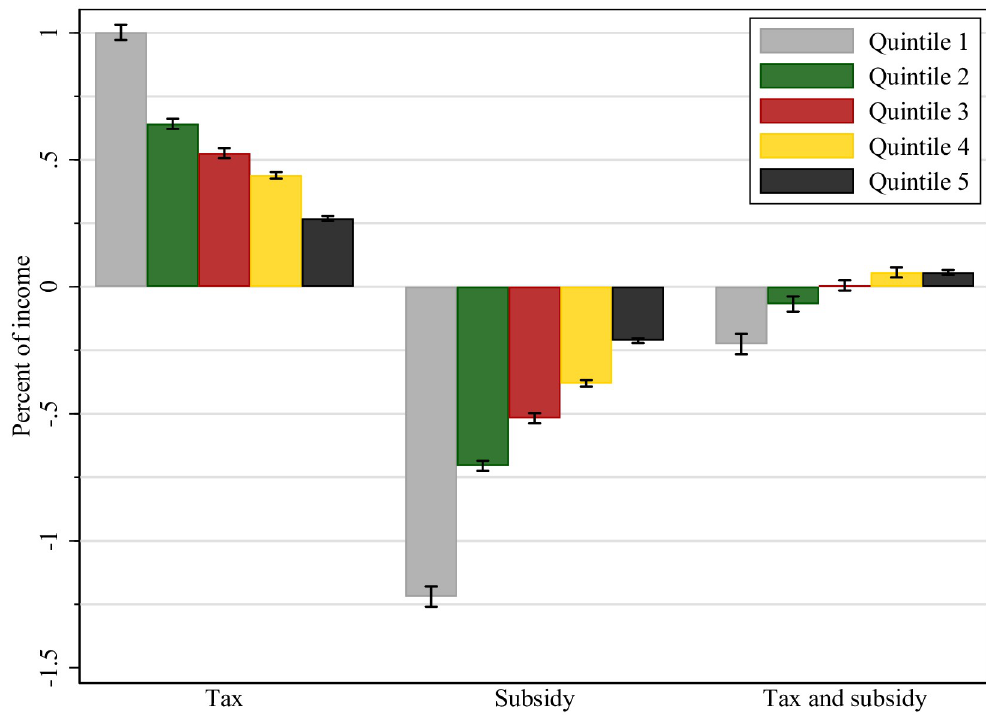
Fig 4. Household welfare change (compensated variation as % of income). Notes: Positive values denote “welfare losses” and negative values denote “welfare gains”. All values are expressed as percentage of household income.